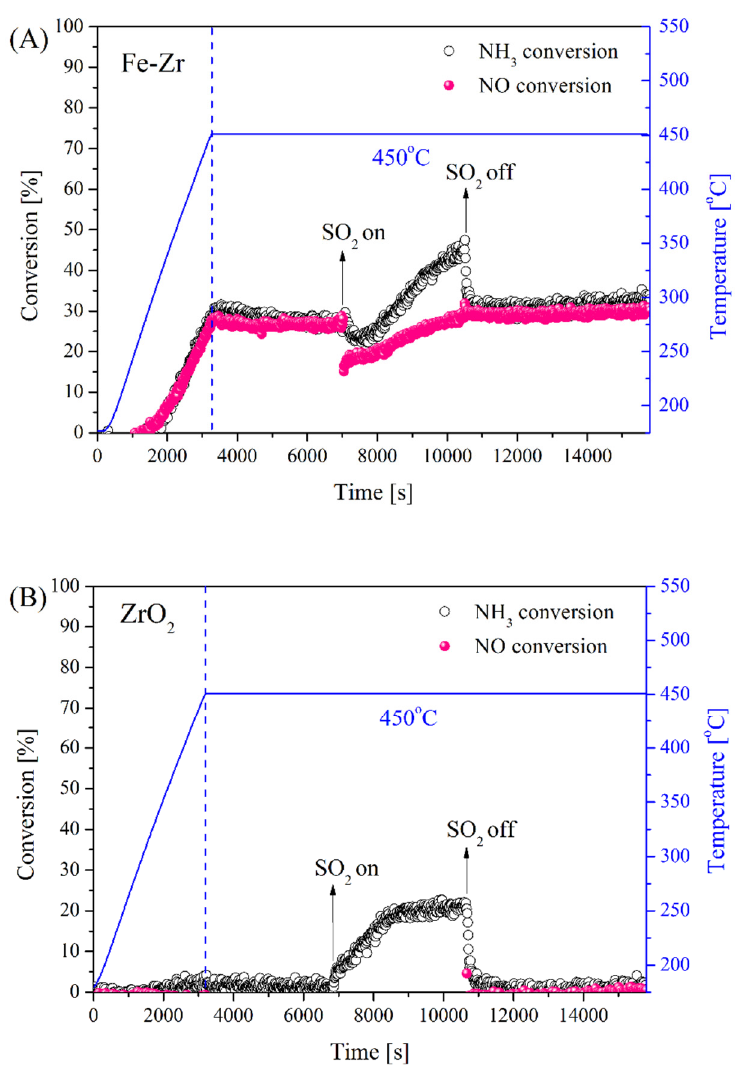
Figure 8. Effect of SO 2 addition during NH 3 -SCR over Fe-Zr and ZrO 2 catalysts in the hydrothermal conditions. ( A ) Fe-Zr catalyst, ( B ) ZrO 2 support. The experimental conditions: [NO] = [NH 3 ] = 1000 ppm, [SO 2 ] = 100 ppm when used, [H 2 O] = 3.5 vol%, [O 2 ] = 2.5 vol% diluted in helium; total flowrate of 100 mL/min.